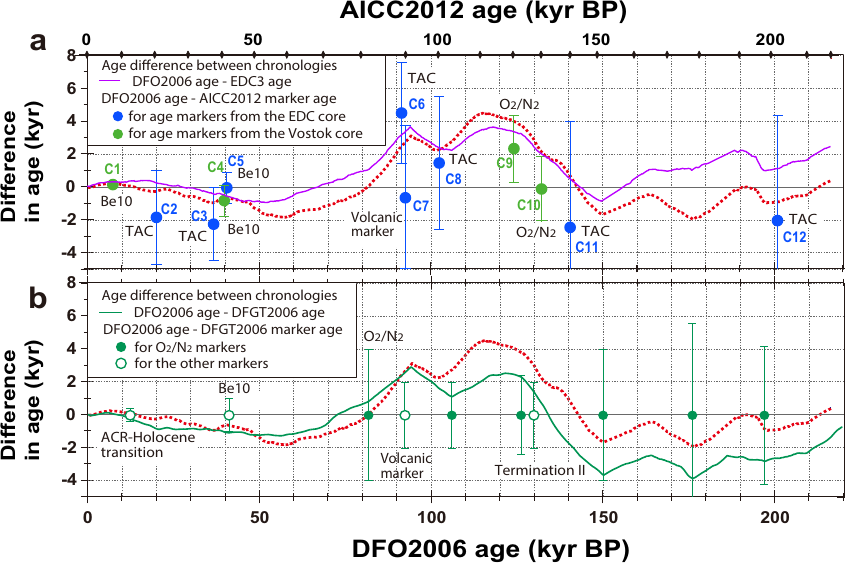
Figure 5. Comparisons between DFO2006 age and AICC2012 age are plotted on a common age scale. Again, as in Fig. 4, we use the DFO2006 scale at the bottom axis with the AICC2012 scale at the top axis. (a) The age difference between the two chronologies [DFO2006 age – AICC2012 age] (red dotted line reproduced from Fig. 4a) is compared with age difference [DFO2006 age – AICC2012 marker age]. Information of the AICC2012 age markers is from Table 4. The age difference [DFO2006 age – EDC3 age] is shown as a purple line. (b) DFO2006 age, the O 2 / N 2 chronology of the DF core is compared with “DFGT2006”, the glaciological chronology of the same DF core. It is shown as [DFO2006 age – DFGT2006 age] (green line in the figure). Although the age markers of the two chronologies have no age differences, DFGT2006 uses a smaller number of markers and has a larger uncertainty setting to less constrain the age by the age markers. We observe that the green line and [DFO2006 age – AICC2012 age] (red dotted line reproduced from Fig. 4a) have similar variations with peak differences at MIS 5b and